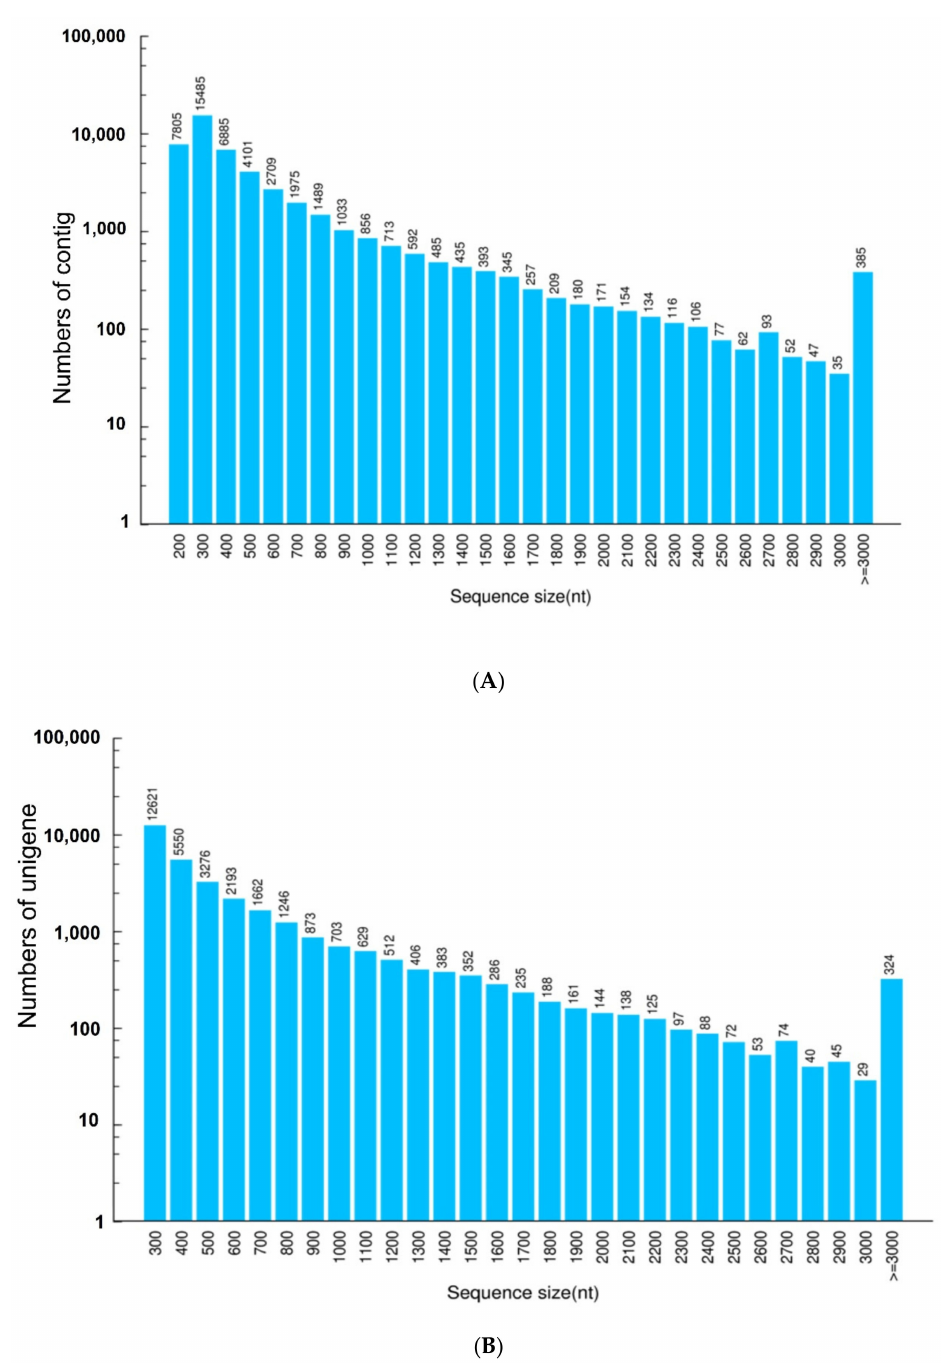
Figure 1. Size distributions of ( A ) contig and ( B ) unigene in the transcriptome of the Latrodectus geometricus venom gland. The sequence size is represented on the x-axis, while the numbers of contig and unigene are represented on the